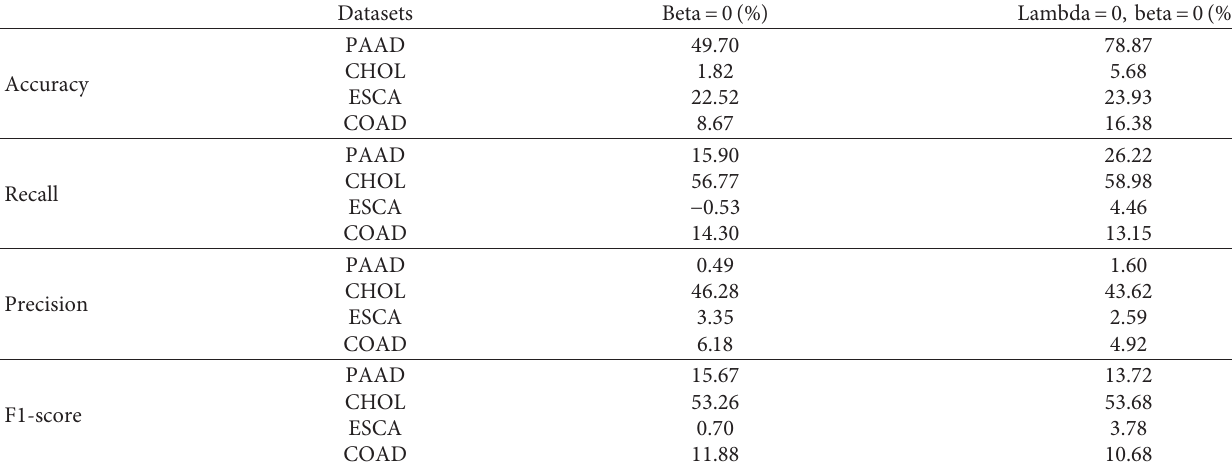
Table 4: The contribution of graph regularization and sparse constraints to clustering